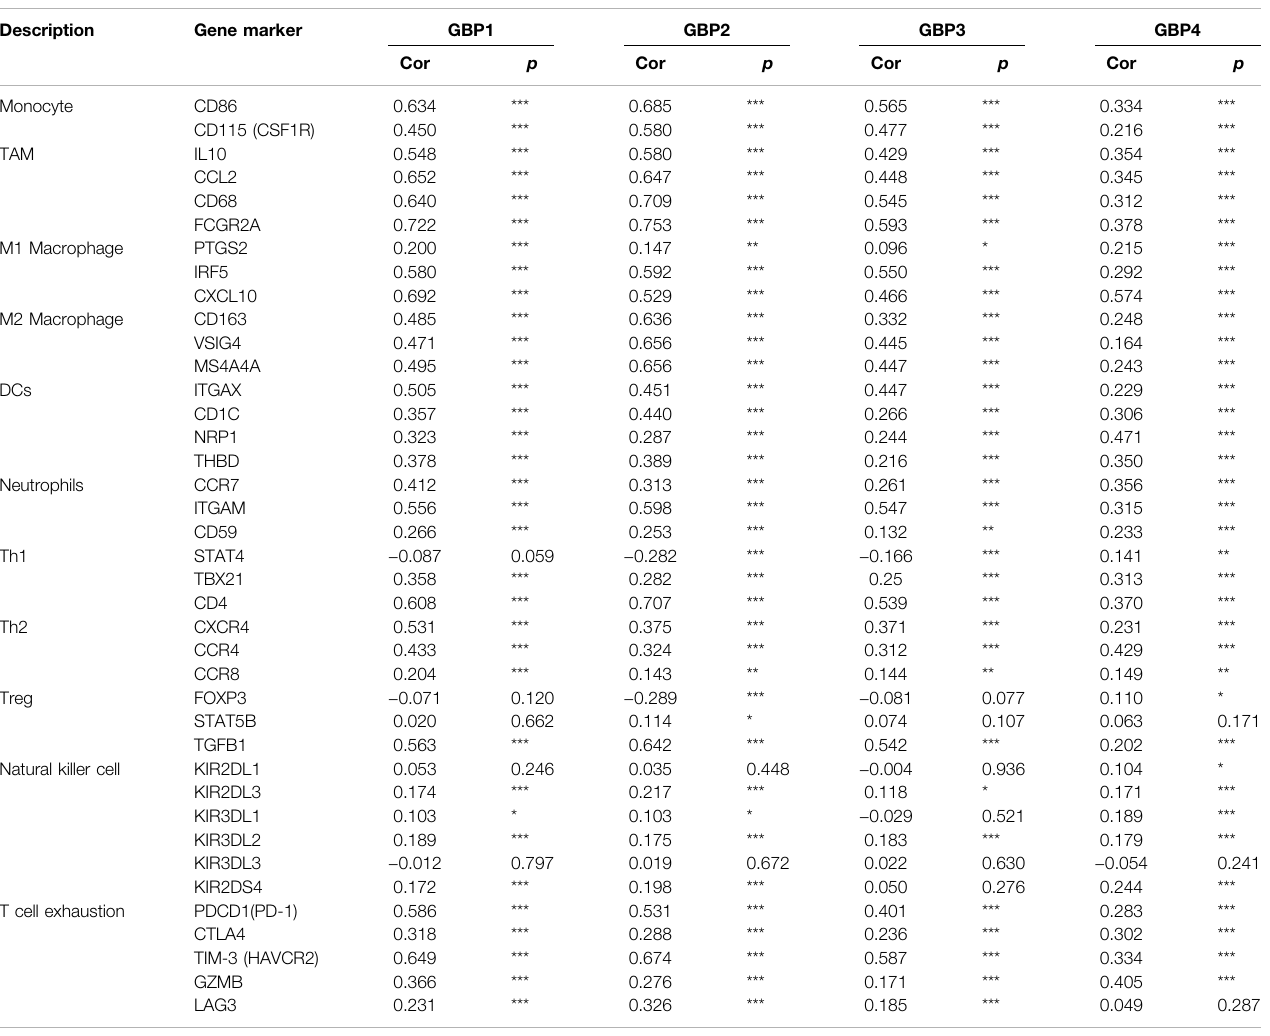
TABLE 4 | Correlation analysis between GBP1/2/3/4 and related markers of immune cells in LGG. Description